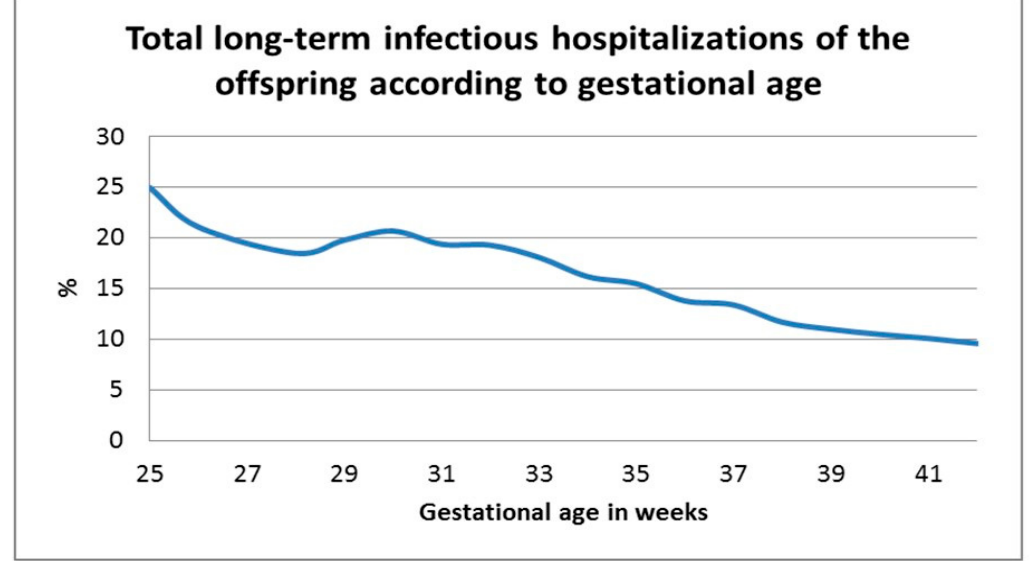
Figure 2. Total long-term infectious hospitalizations of the o ff spring according to gestational